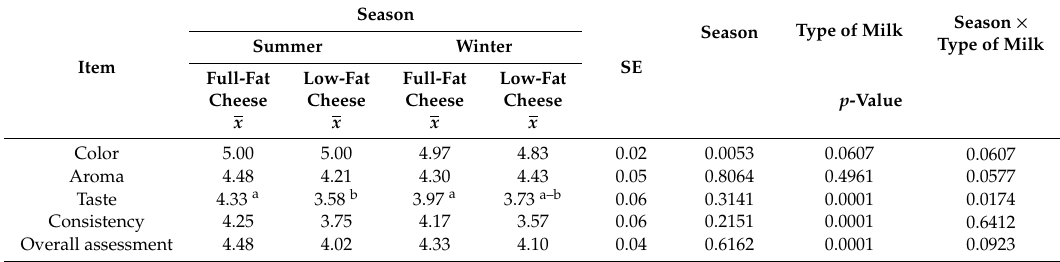
Table 4. Organoleptic assessment of the cheeses depending on the season and the type of milk.